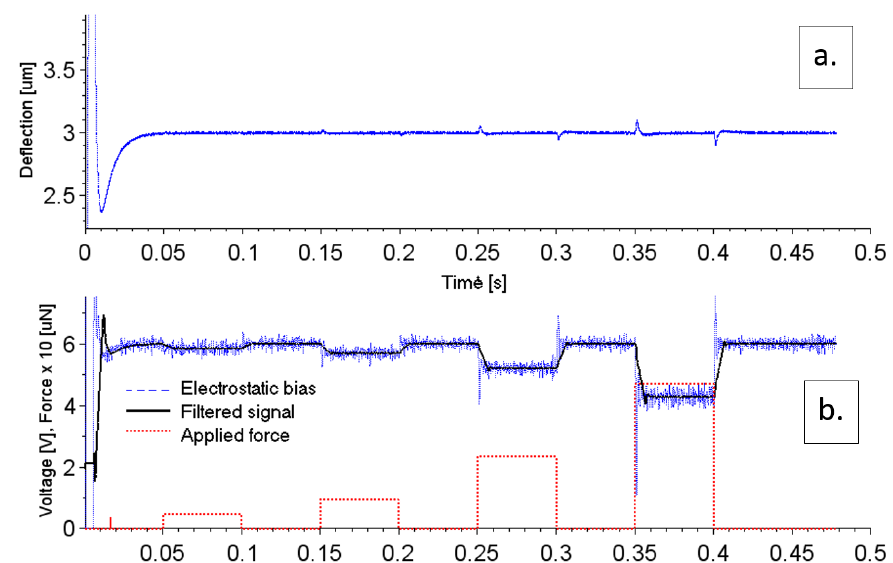
Figure 8. Transient response of the simulated closed feedback system to initial conditions (at the controller start-up) and application of a stepwise increase of external measured force. The initial ramp-up shows a strong overshoot in deflection signal caused by corrective controller action to a large initial difference between actual deflection and setpoint. The best achieved rise time is shown here. At lock, the sensor’s deflection ( a ) is kept constant by the compensating controller’s effort except for a short transient overshoot after application of the step force. The controller’s corrective effort ( b ) proportionally decreases as the input force increases.